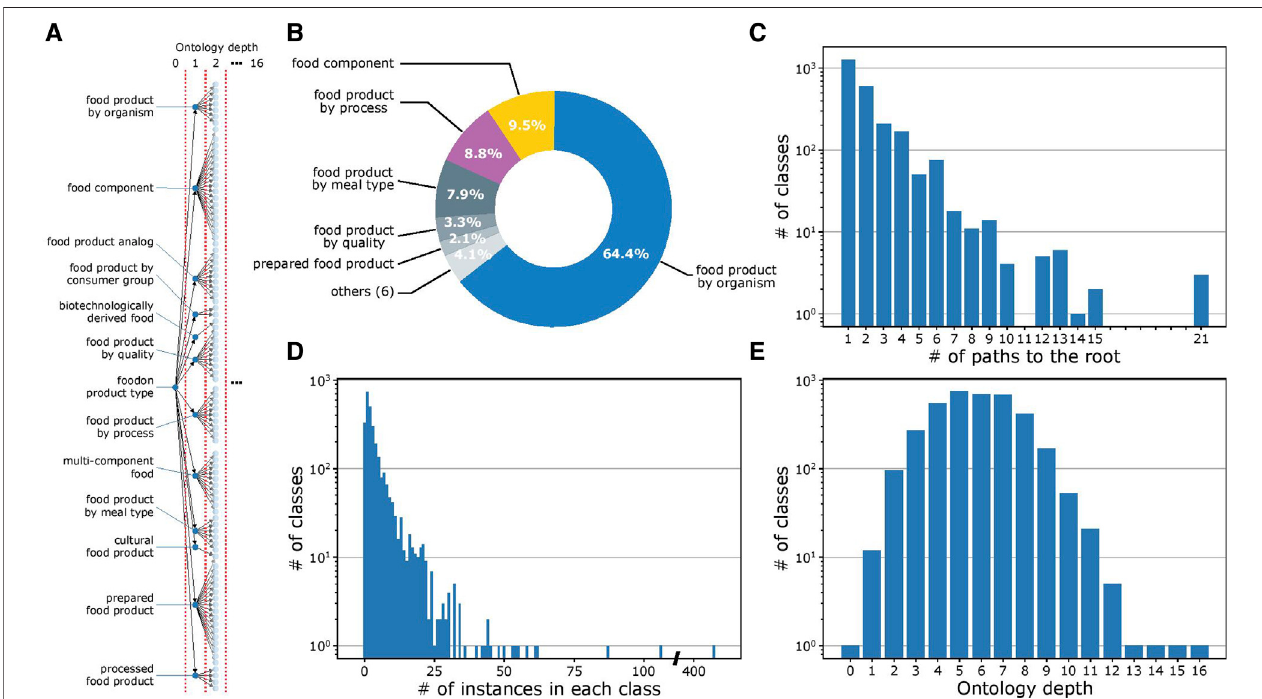
FIGURE 2 | FoodOn structure analysis. (A) Visualization of the partial FoodOn class hierarchy. FoodOn contains 10,865 food instances (not shown here) that are mapped to one or more of the 2,764 classes. All classes in FoodOn branch out from a single root class "foodon product type" located at depth 0. (B) Pie chart showing theproportionofsubclassesforeach ofthe12classesinthehighest,i.e.,the fi rst,leveloftheontology.Eachoftheseclassesrepresentsoneofthe12featuresofafood item. (C) Histogram showing the number of paths to the root class for each of the 2,764 classes. Number of paths considers the multi-parent architecture. (D) Histogram showing the number of instances in each class. Only 2,433 of 2,764 classes have instances. Certain classes only have subclasses aimed at providing further levels of differentiation. The vast range in instances per class indicates that specialized classes with fewer instances are more typical to the ontology, though there are some classes with up to 100s of instances. (E) Histogram showing the number of the target classes at the respective ontology depth. This representation de fi nes the ontology depth of the class as the number of intermediate classes in a path connecting it to the root